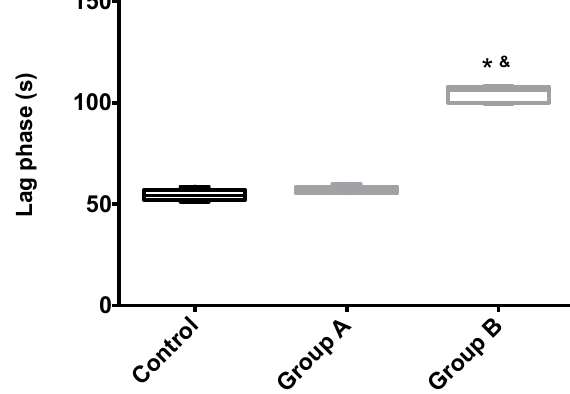
Figure 6. The effects of I/R with or without BBR (18.6 mM) supplementation on hepatic mitochondrial lag phase time. Mitochondria were isolated from animals sacrificed after 12 h of hepatic exposure to preservation solution and 1 h of reperfusion, as described in the Materials and Methods Section. Control animals were sham operated. Lag phase time was evaluated with a TPP + -sensitive electrode. Mitochondria isolated from the I/R group (Group B) had a significant increase in the lag phase (required amount of time to phosphorylate the same amount of ADP) when compared to the control group, while the supplementation with BBR (Group A) was sufficient to prevent said alterations. Data are the means ± 5–95 percentile of at least 2 different experiments, performed with 10 animals/group. * indicates a statistically-significant difference ( p < 0.05) against the control group; & indicates a statistically-significant difference ( p < 0.05) against Group A.